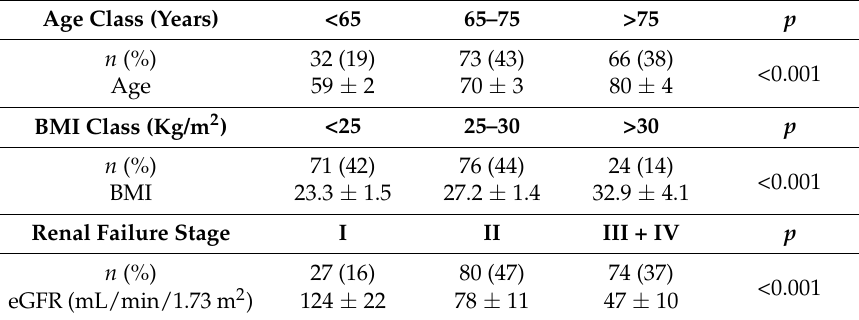
Table 4. Description of class variables.